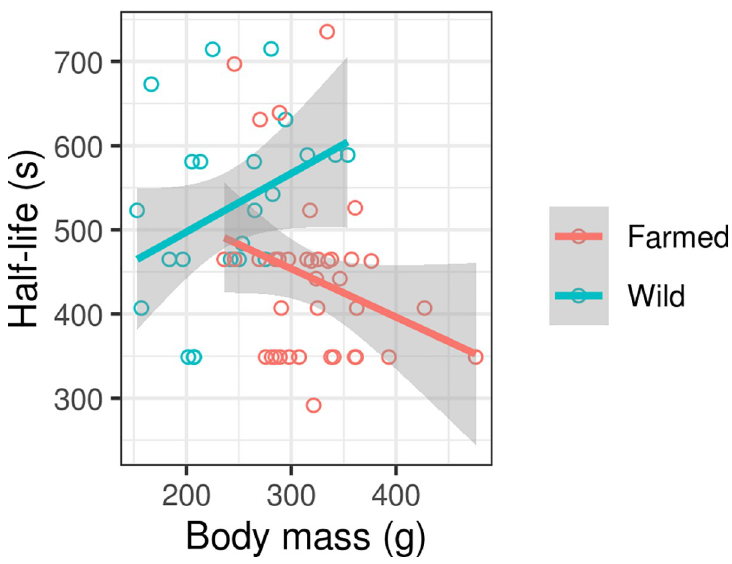
Fig 6. Variation in bioluminescent bacterial half-life (inversely related to complement activity) following exposure to 20-day-old mallard plasma (n = 61). Predictions are based on mixed models and shaded areas correspond to 95% confidence